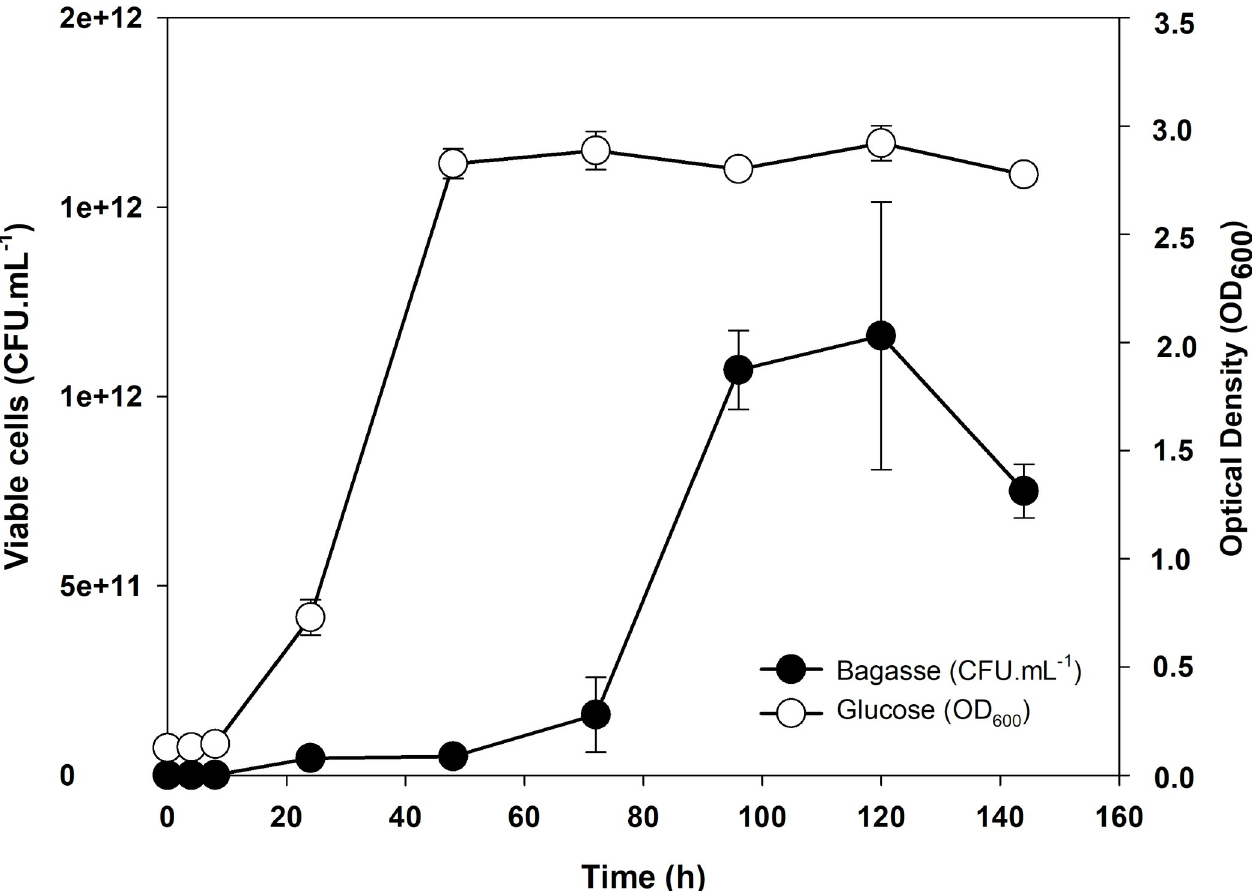
Fig 5. Bacterial growth curves of Chitinophaga sp. (CB10), in a solid BHB culture medium with sugarcane bagasse by Colony Counting Unit (CFU) and in a liquid BHB culture medium added with glucose by reading Optical Density (DO 600 ).